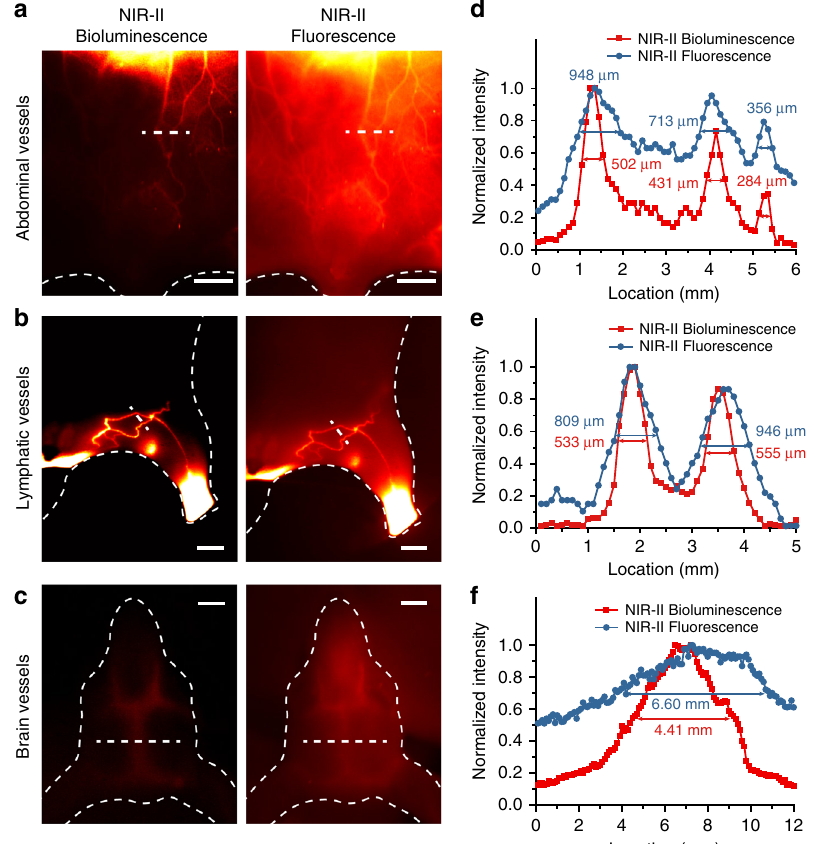
Fig. 5 Comparing blood vessels and lymphatics imaging between NIR-II bioluminescence and fl uorescence signals. a – c NIR-II bioluminescence imaging (left) and NIR-II fl uorescence imaging (right) on abdominal vessels ( a ), lymphatics ( b ) and brain vessels ( c ) in mice after intravenous injection of NIR-II- BPs. Scale bar, 5 mm. d – f Intensity pro fi les of abdominal vessels, lymphatics and brain vessels along the white line in a – c . Source data underlying d – f are provided as a Source Data fi